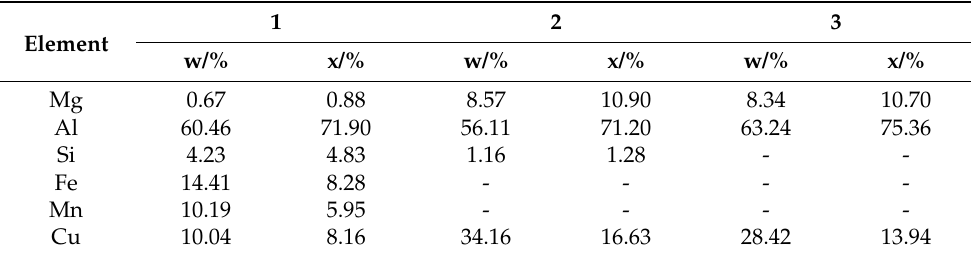
Figure 3. The scanning electron microscopy (SEM) image of the precipitated phase structure of 2A12-T4 aluminum alloy. Table 3. Composition of the precipitated phase of 2A12-T4 aluminum alloy tested using energy spectrum analysis (EDS).